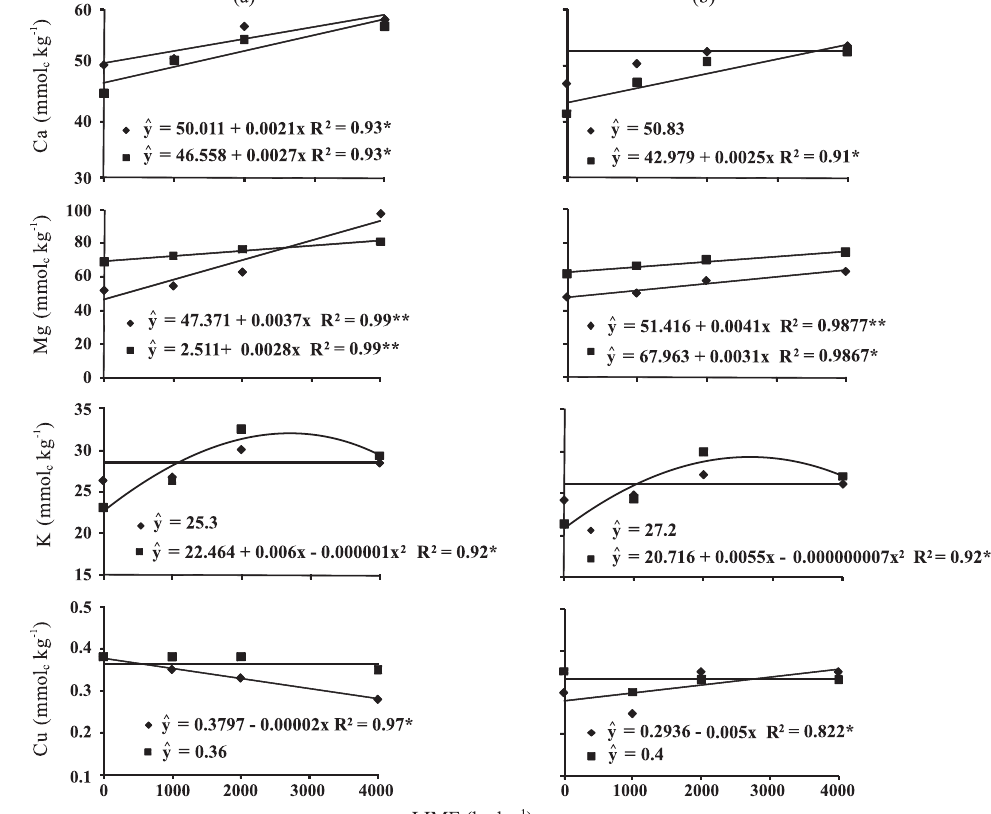
Figure 3. Contents of water-soluble calcium, magnesium potassium and copper in plant extracts of white oat at flowering as related to surface liming. ( ) without gypsum and ( ) with gypsum in 2004/2005 (a) and 2005/2006